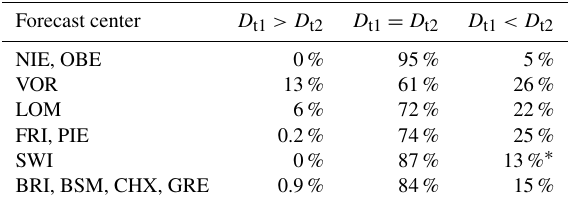
Table 5. Temporal differences in danger rating within forecast pe- riod with D t1 , the danger rating valid for the first time step, and D t2 , the danger rating valid for the second time step. Example distribu- tions are provided for some forecast